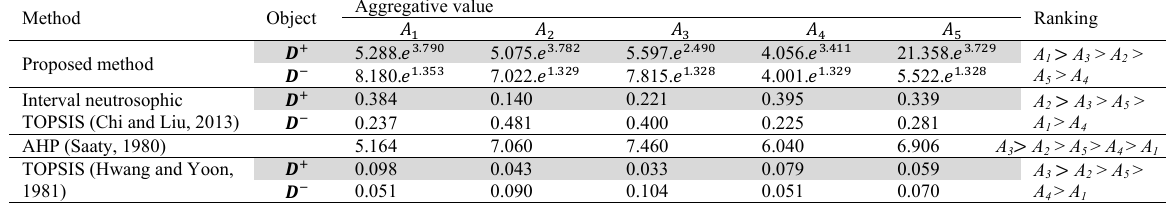
Comparison of interval complex neutrosophic TOPSIS with other methods of lecturer evaluation Method Object Proposed